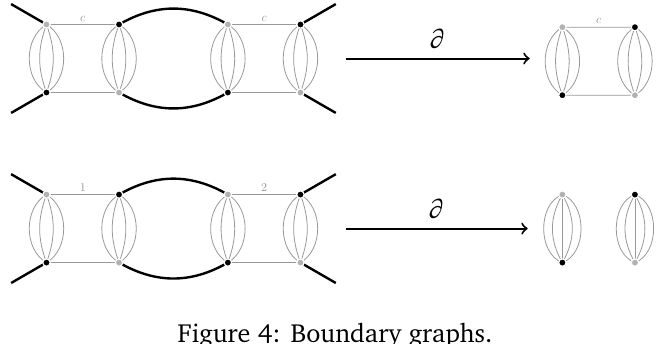
Figure 4: Boundary